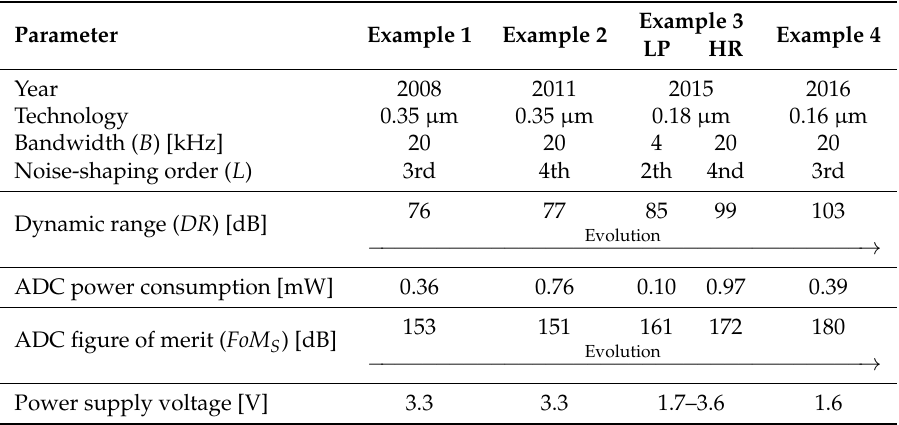
Table 7. Evolution of MEMS microphone interface circuits